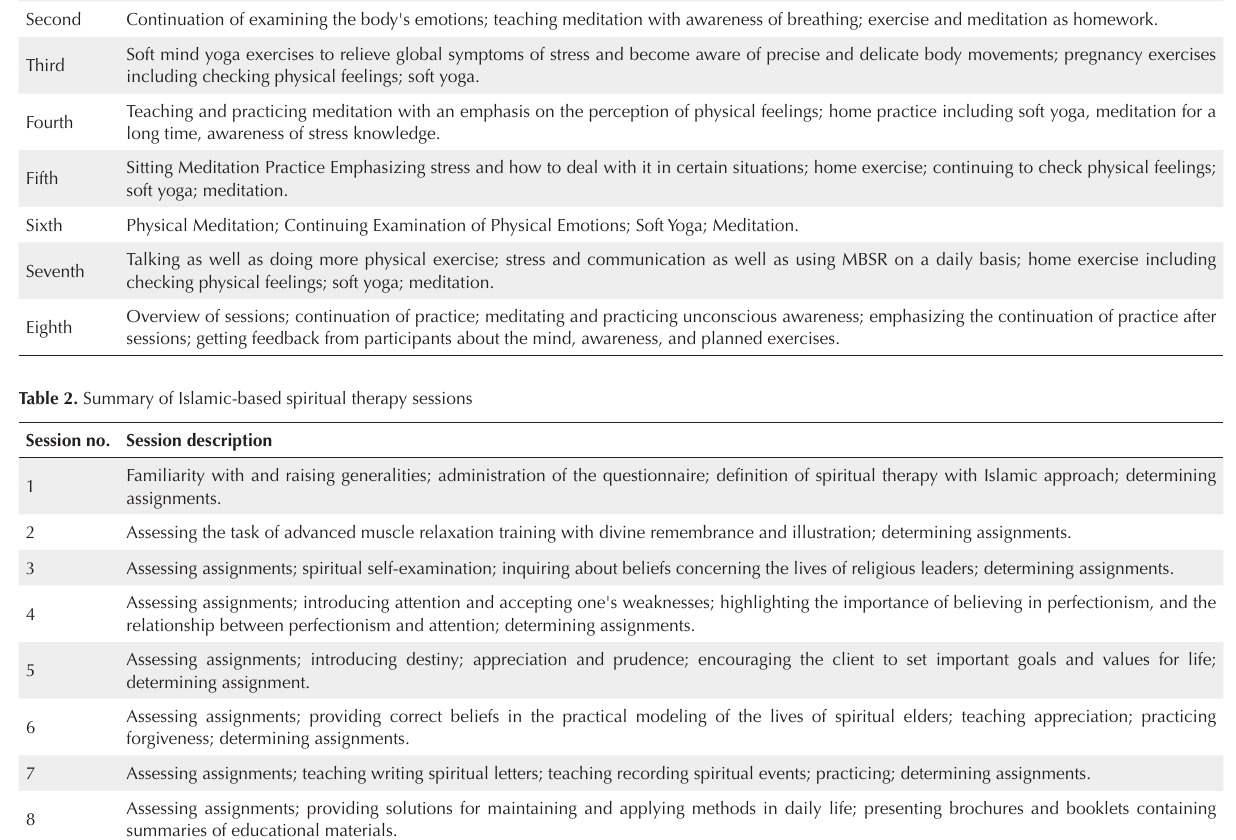
Table 3. The demographic characteristics of studied groups Groups